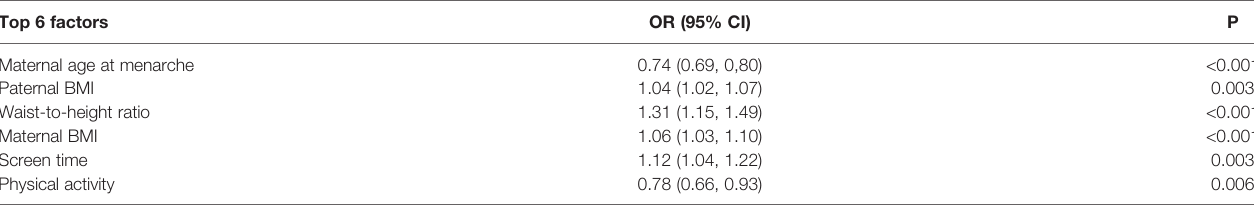
TABLE 5 | The risk prediction of top 6 variables for precocious puberty using the Logistic regression model.